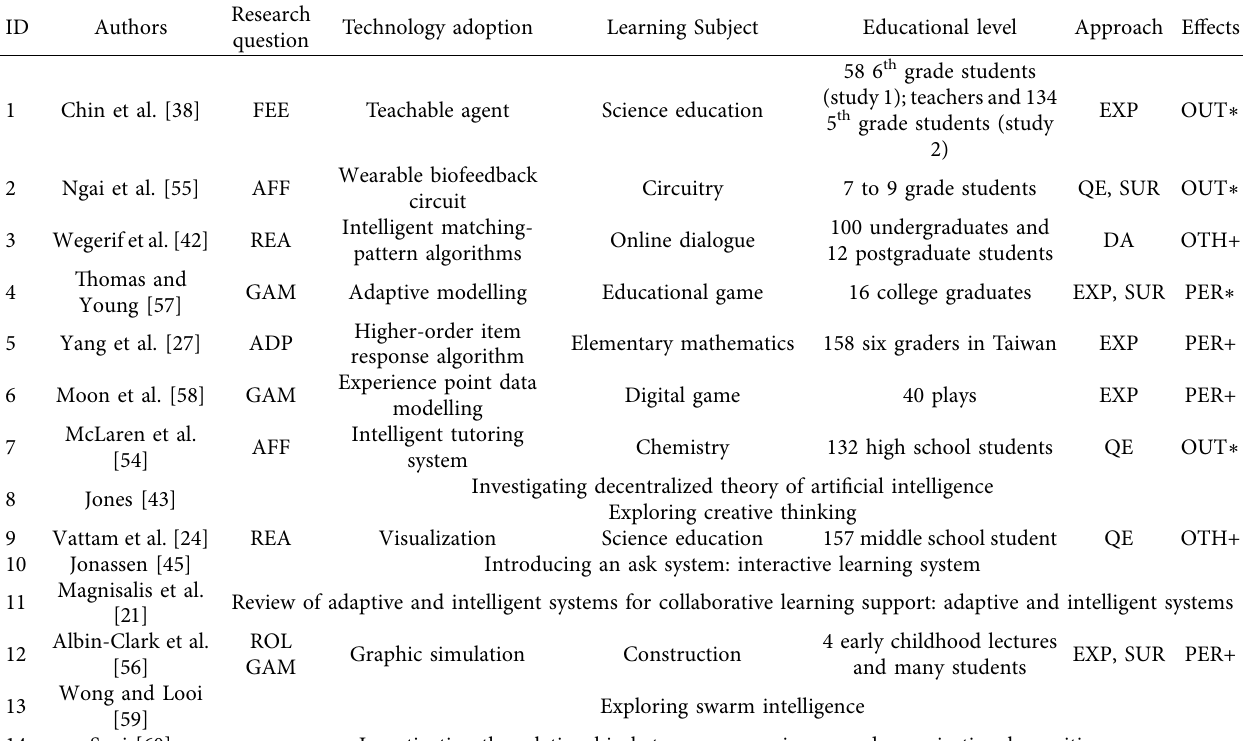
Table 1: The articles coded by research question, technology adoption, learning subject, educational level, research approach, and effects. ID